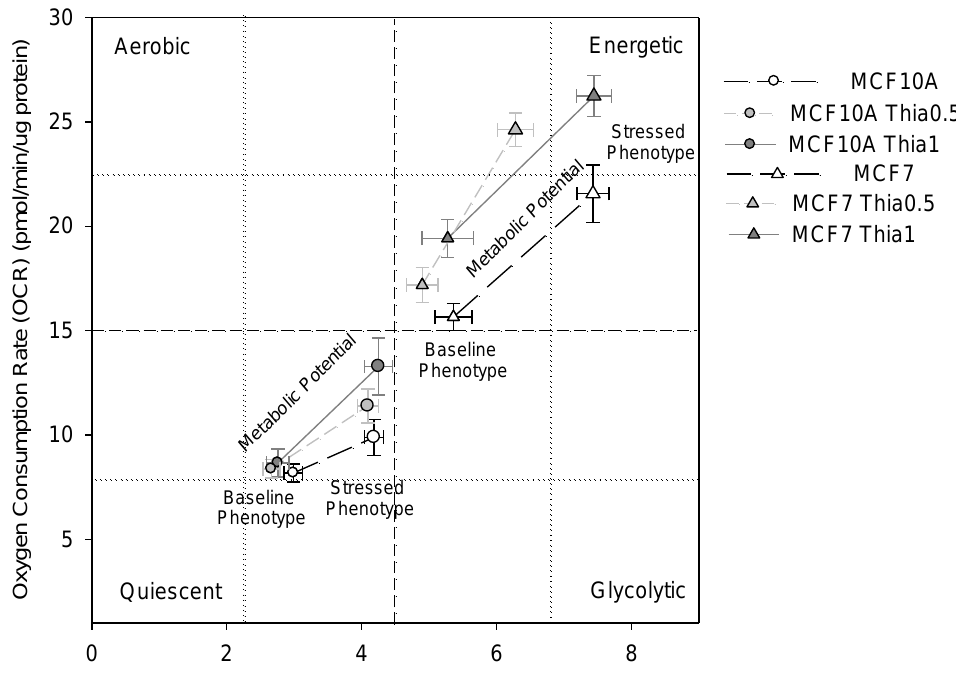
Figure 5. Cell Energy Phenotyping. Cells were treated with a range of doses of thiamine for 24 h before cell energy phenotyping (Seahorse Bioscience, Billerica, MA).